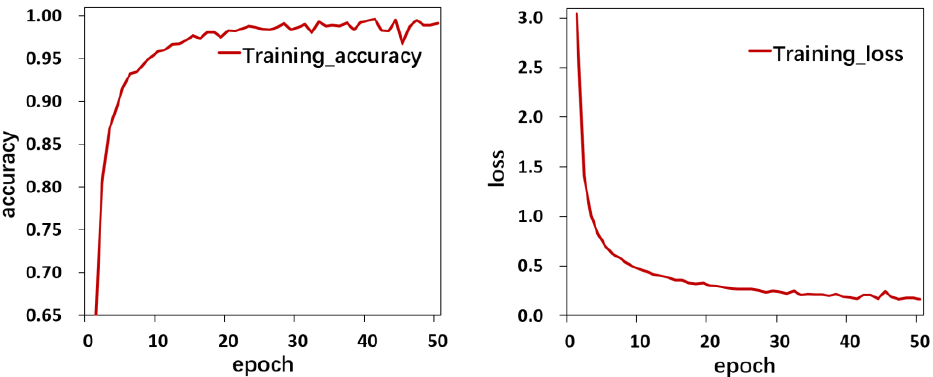
Figure 11. Training accuracy and loss in 1D-U-Net for lixel classification.